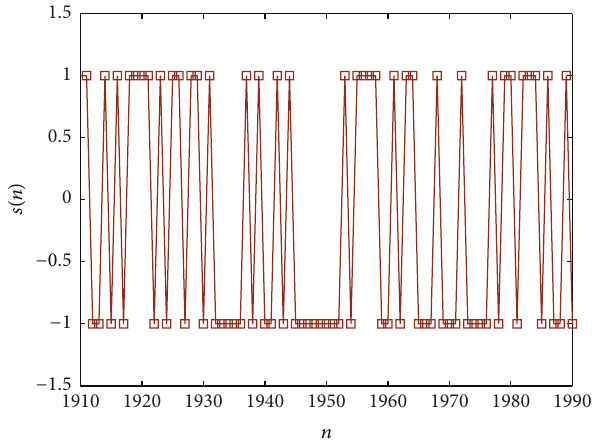
Figure 2: Chaos sequence for 𝜇 = 4 , 𝑥 0 = 0.329999 , and 𝑁 = 2000 . Figure 3: Chaos sequence for 𝜇 = 4 , 𝑥 0 = 0.329998 , and 𝑁 = 2000 .